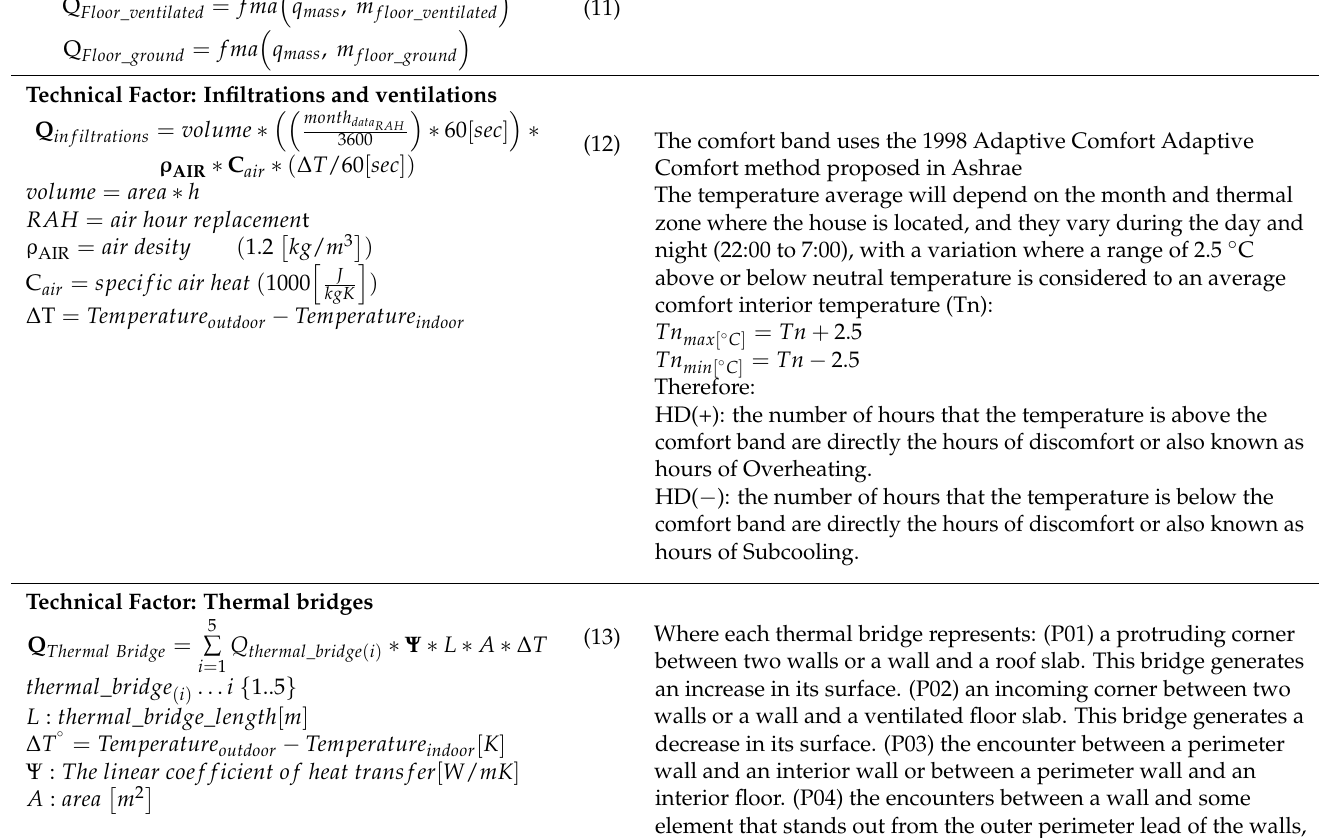
Where each thermal bridge represents: (P01) a protruding corner between two walls or a wall and a roof slab. This bridge generates an increase in its surface. (P02) an incoming corner between two walls or a wall and a ventilated floor slab. This bridge generates a decrease in its surface. (P03) the encounter between a perimeter wall and an interior wall or between a perimeter wall and an interior floor. (P04) the encounters between a wall and some